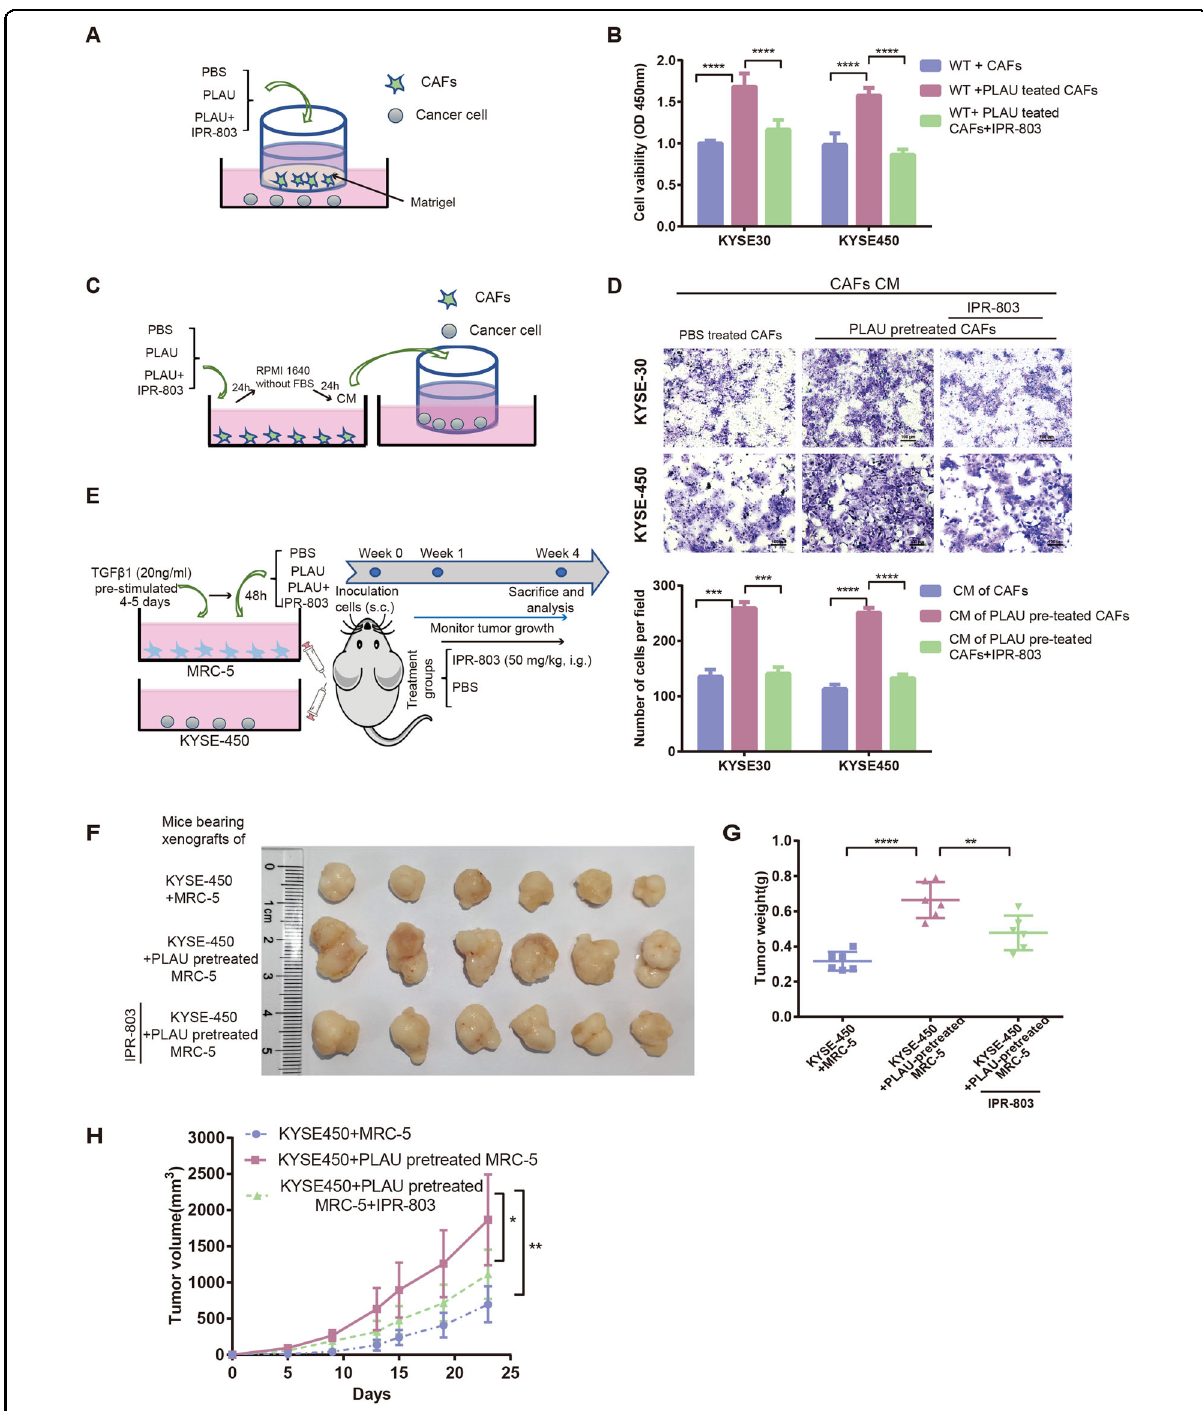
Fig. 5 CAFs stimulated by PLAU promoted ESCC proliferation and migration. A , B Experimental scheme and growth of WT KYSE-30 and KYSE- 450 cells cocultured with CAFs with or without recombinant PLAU in the presence or absence of the PLAU-uPAR inhibitor IPR-803 treatment. CCK8 assays were performed after co-culture for 48 h. C , D Experimental scheme and migration ability of WT KYSE-30 and KYSE-450 cells with CM of CAFs with or without recombinant PLAU pretreatment in the presence or absence of IPR-803. The numbers of migrating cells were compared between the groups (the bottom panel). E – H Outline experimental scheme ( E ), tumor volume ( F ), and weights ( G ) and growth curves (H) of subcutaneous tumor xenografts established from co-implantation of WT KYSE-450 cells, and indicated MRC-5 cells in the presence or absence of IPR-803 treatment (female 6-week-old to 8-week-old nude mice, n = 6 per group). Three biological replicates were performed for in vitro assays. Three biological replicates were performed for in vitro assays. Data in bar charts are presented as the mean ± SD. * P < 0.05, ** P < 0.01, *** P < 0.001, **** P < 0.0001 (Student ’ s t